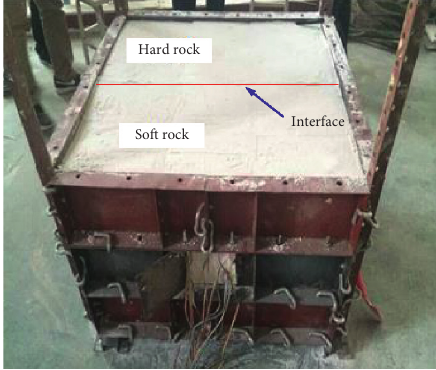
Figure 4: Test box of seismic simulation.